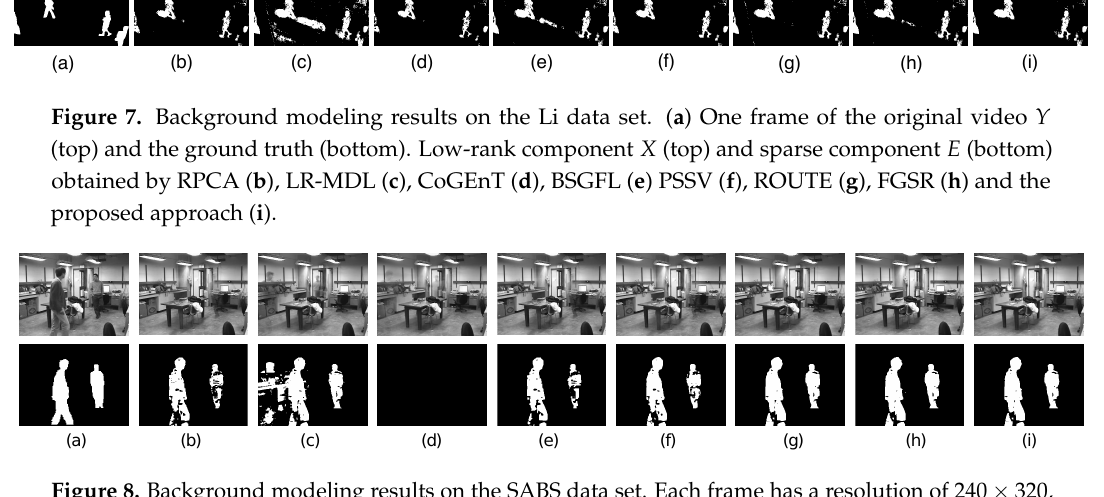
Figure 8. Background modeling results on the SABS data set. Each frame has a resolution of 240 × 320, and we stack the frames as the columns in our observed matrix Y ∈ R 76800 × 100 . ( a ) One frame of the original video Y (top) and the ground truth (bottom). Low-rank component X (top) and sparse component E (bottom) obtained by RPCA ( b ), LR-MDL ( c ), CoGEnT ( d ), BSGFL ( e ) PSSV ( f ), ROUTE ( g ), FGSR ( h ) and the proposed approach ( i